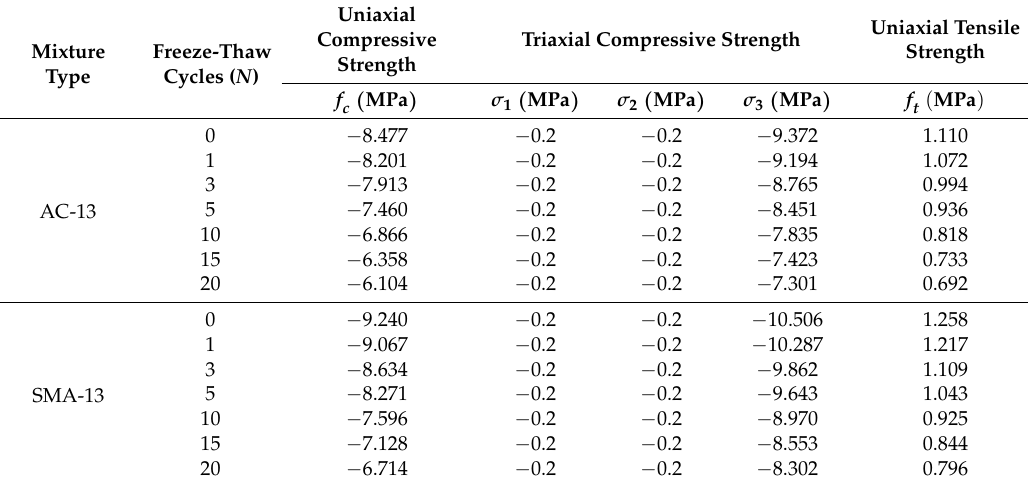
Table 7. Failure strength of asphalt mixtures after freeze-thaw cycles.